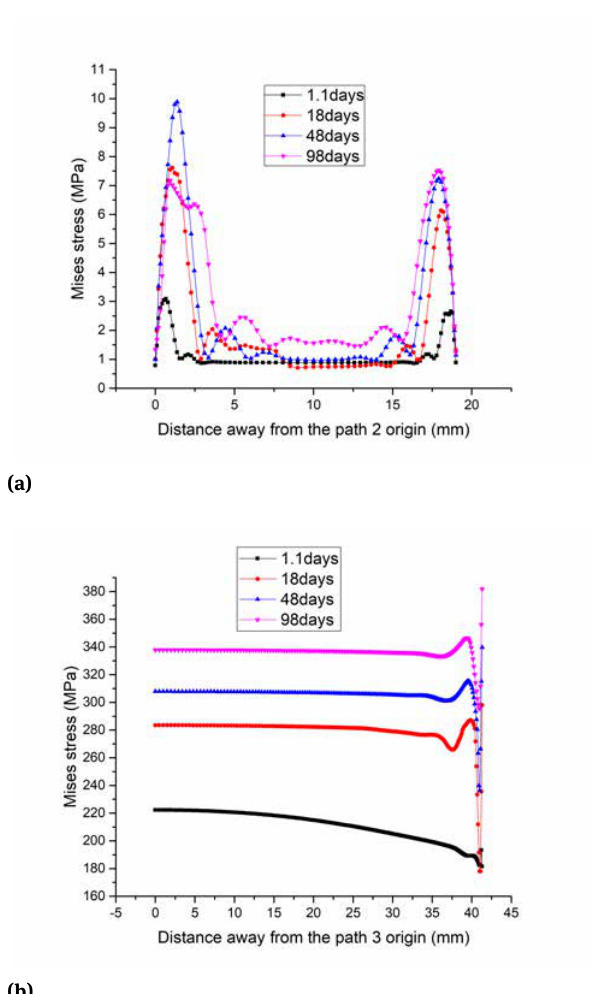
Figure 19: The evolution of Mises stresses: (a) Mises stresses in path 2; (b) Mises stresses in path 3; (c)Normalized Mises stress in path